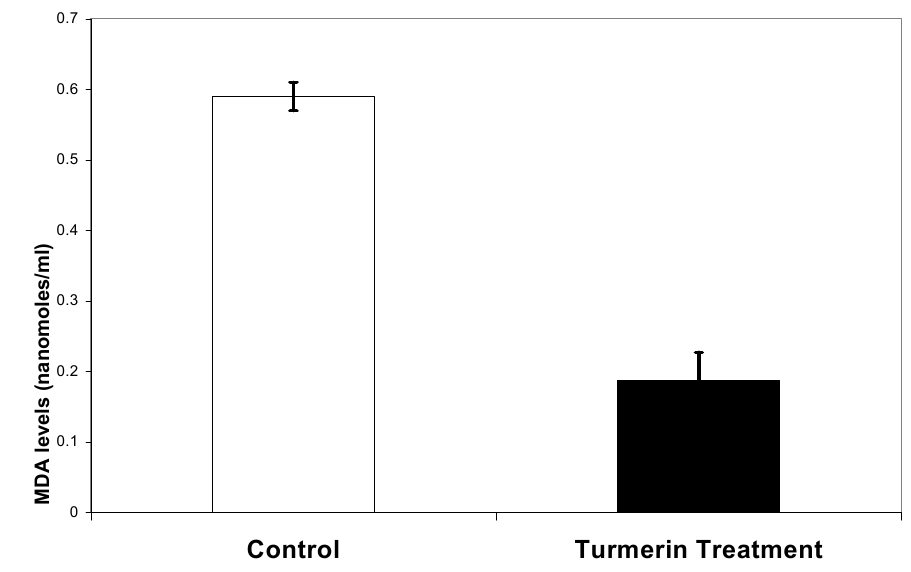
Figure 3. Lipid peroxidation as measured by conjugated dienes